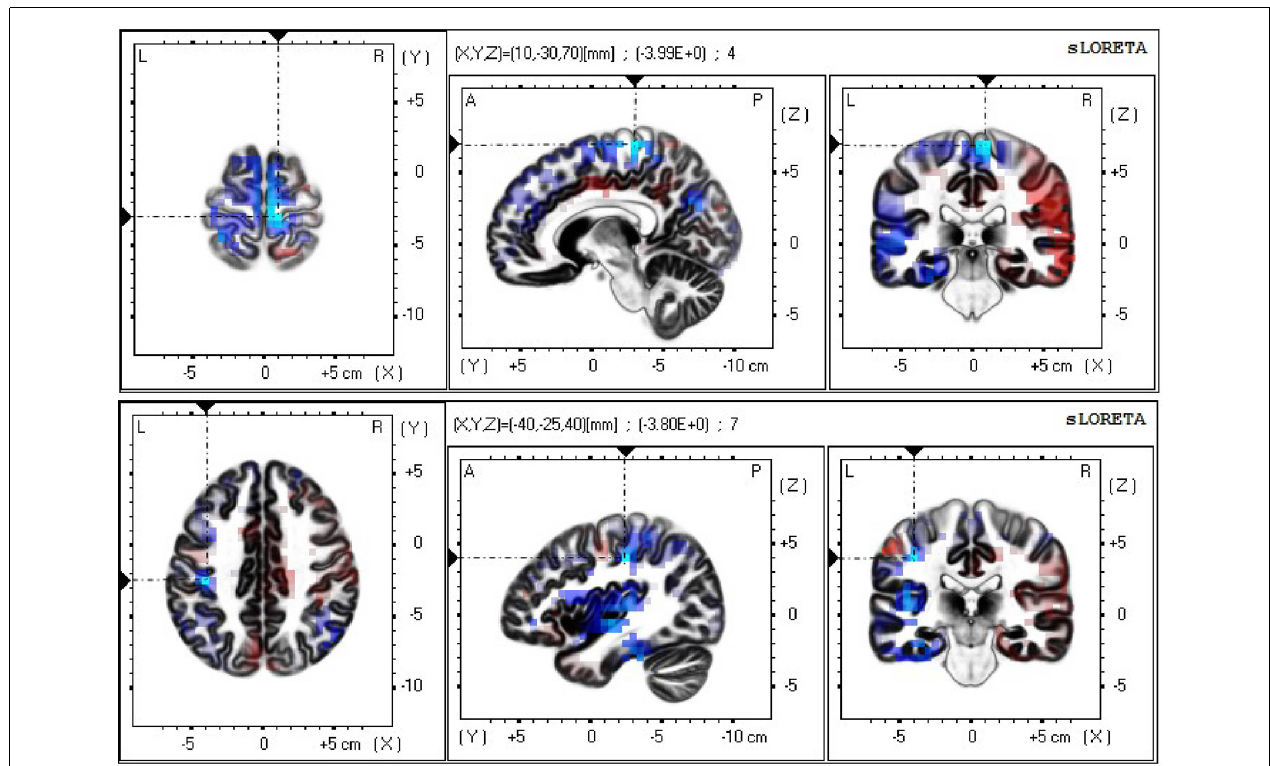
FIGURE 3 | Current density power analysis in the mu/alpha band (8–13 Hz), averaged across 22 participants, between the neutral face and non-biological stimulus conditions during the late epoch found significant voxels ( p < 0.05) best matched to the supplementary motor area (top) and the primary somatosensory area (bottom). Horizontal (left), sagittal (middle), and coronal (right) sections through the voxel with the maximal t -statistic (local maximum) are displayed. Blue indicates less power in the alpha band in the neutral face than the non-biological stimulus